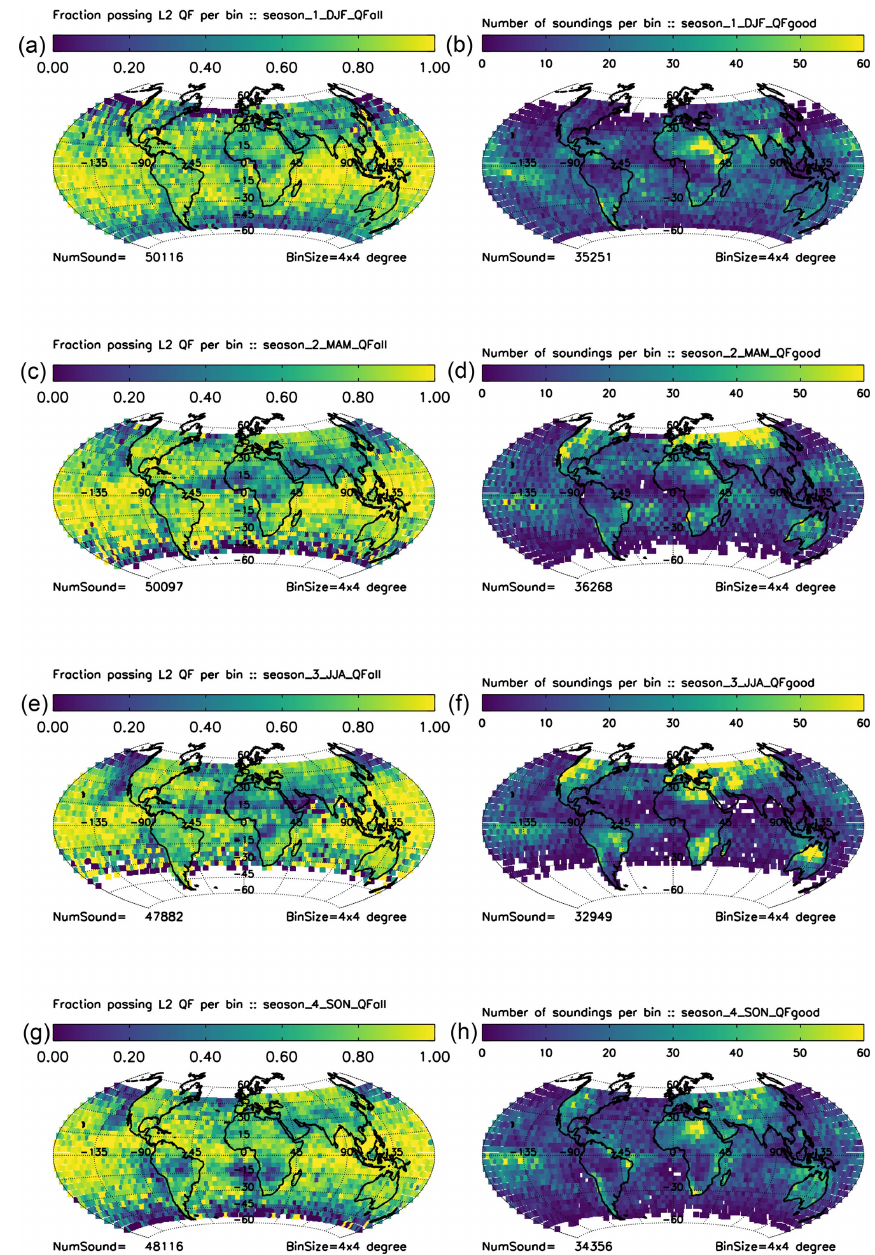
Figure 13. Maps of the seasonal throughput (a, c, e, g) and the resulting sounding densities (b, d, f, h) in 4 ◦ latitude–longitude bins for soundings assigned a good QF. Inflate densities by 240 to account for on-orbit spatiotemporal